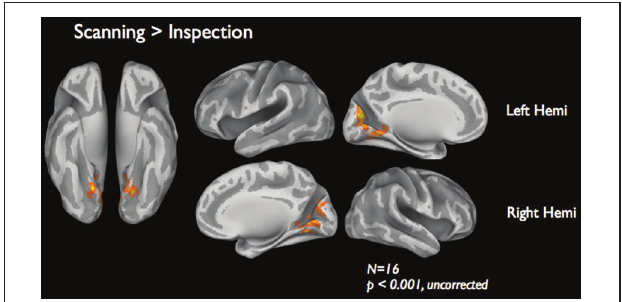
FIGURE 5 | fMRI results of the direct comparison “scanning” > “inspection” . Results are based on 16 subjects presented at a lenient threshold of p < 0.001,